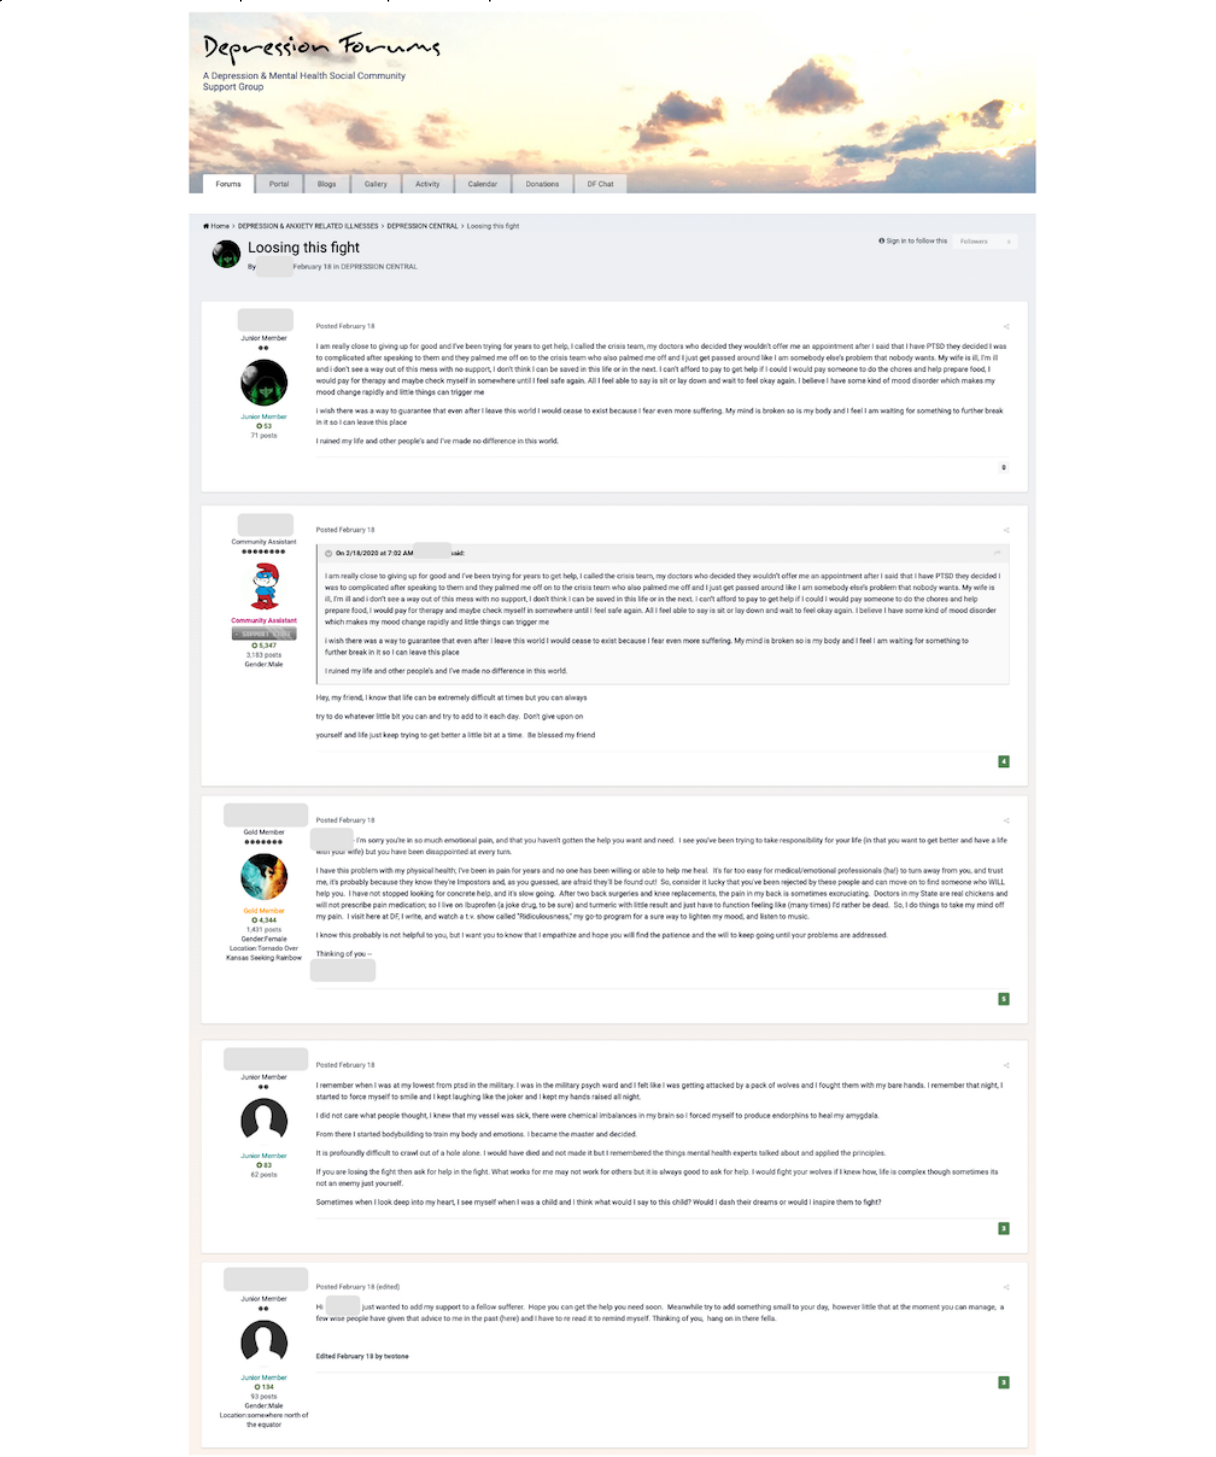
Figure 3. Screenshot of the depression forum’s posts and replies. The virtual identities of the forum users are